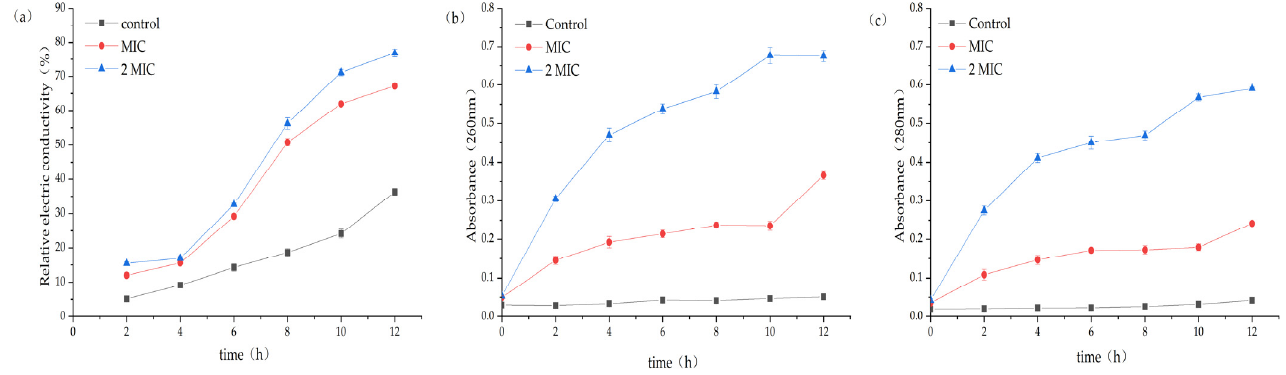
Figure 3. ( a ) Effect of MA on the electrical conductivity of S. aureus culture. ( b ) Effect of MA on Nucleic acid leakage of S. aureus culture. ( c ) Effect of MA on protein leakage of S. aureus culture.